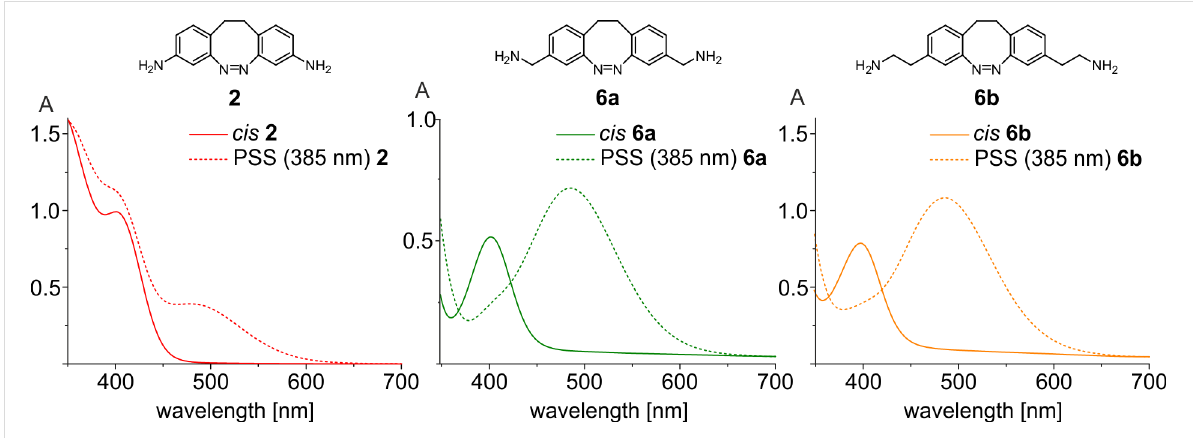
Figure 3: UV–vis spectra of 3,3’-diaminodiazocine 2 (left), 3,3’-di(aminomethyl)diazocine 6a (center), and 3,3’-di(aminoethyl)diazocine 6b (right). Continuous lines: 100% cis and dashed lines: PSS (385 nm) at 298.15 K in acetonitrile.